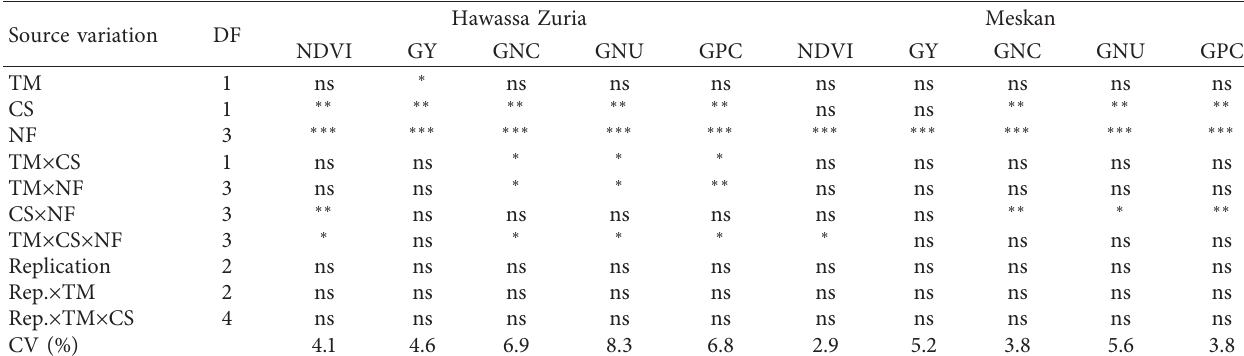
Table 3: Analysis of variance of NDVI, grain yield, nitrogen uptake, and protein content of maize grown at the two sites. Source